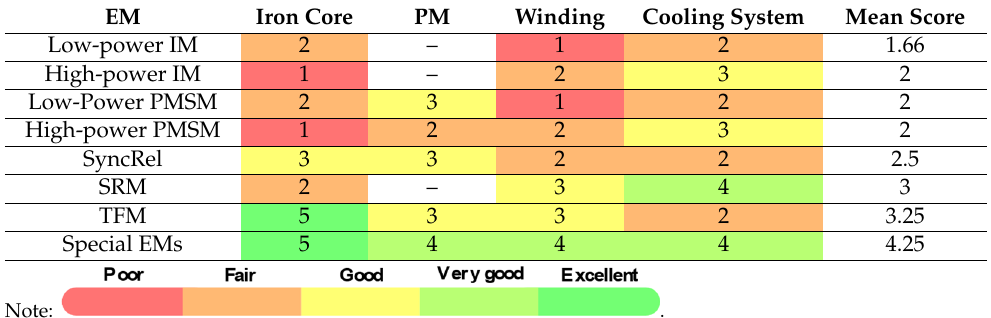
Table 2. Impact score of applying AM to the fabrication of diverse parts of the most typical EMs. EM Iron Core PM